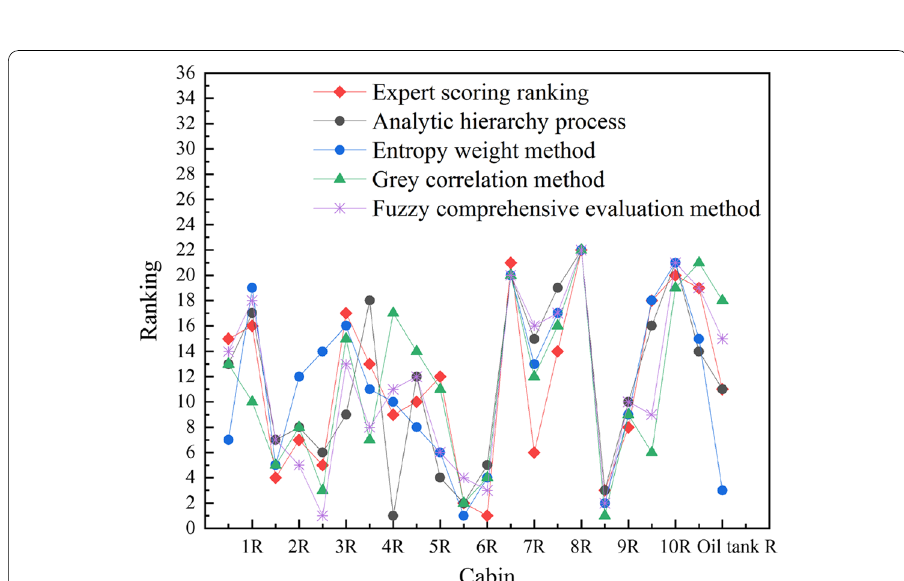
Fig. 5 Comparison of ranking results of different evaluation